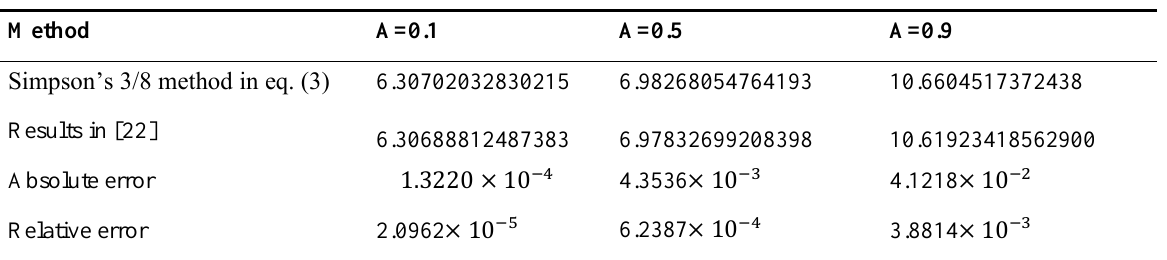
Table 1. Numerical results in (3) compared with the exact solution in paper [22], in different values of A, where n=60.